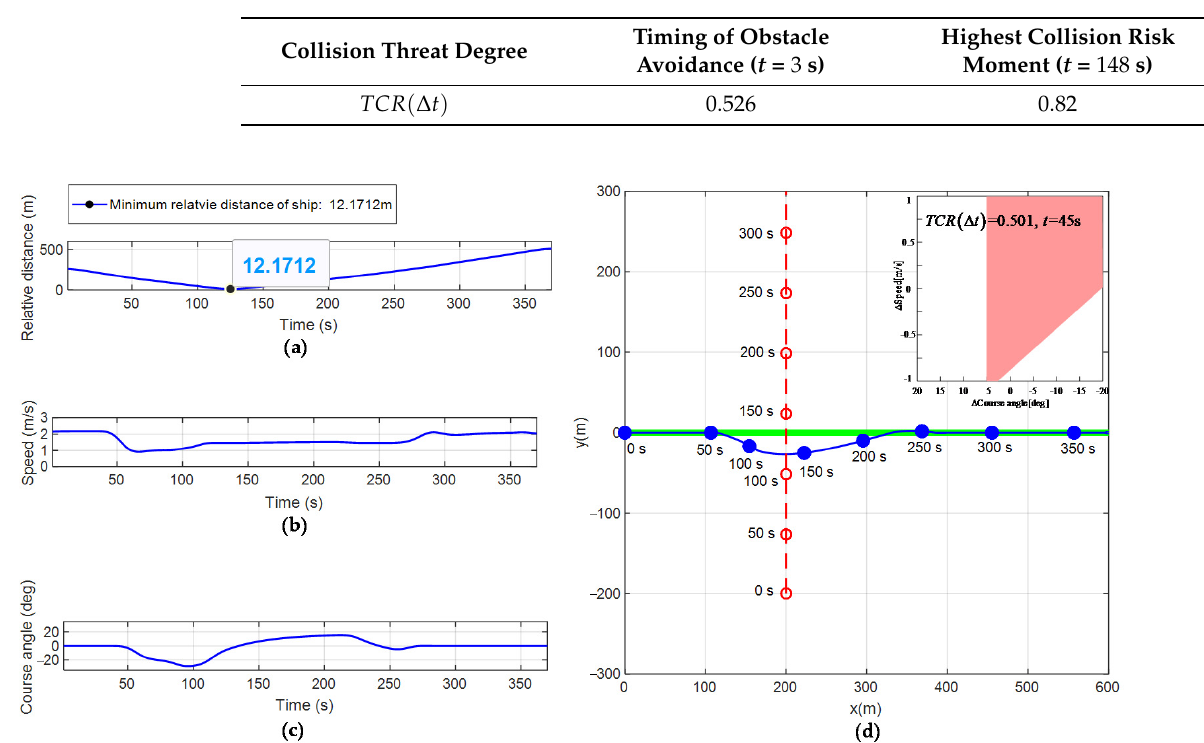
Table 7. Critical moment collision threat degree assessment results. Table 5. Critical moment collision threat degree assessment results.